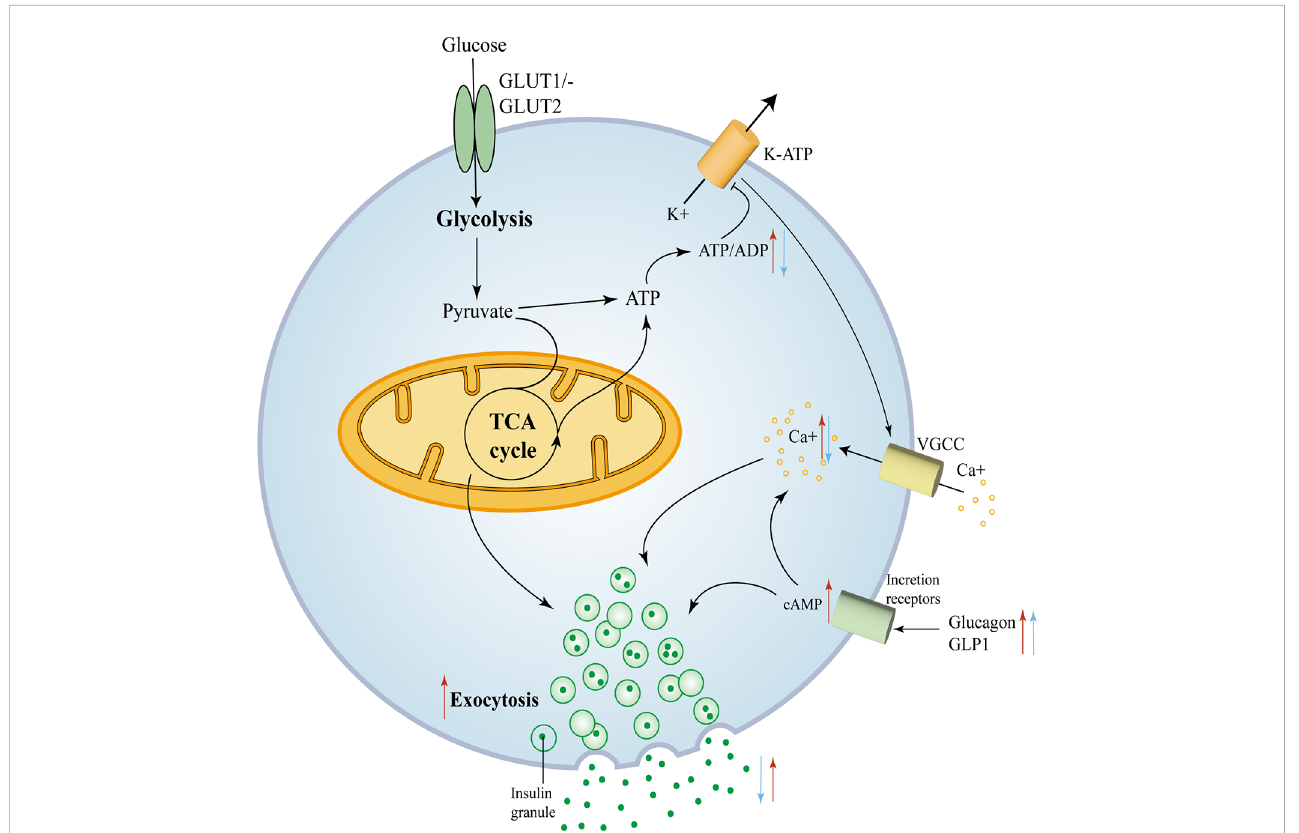
FIGURE 3 FOXA1 and FOXA2 control insulin secretion in mature Β cells. FOXA1 and FOXA2 control insulin secretion in mature Β cells. Glucose enters the Β cell and moves into the glycolytic pathway and is then oxidized through the tricarboxylic acid (TCA) cycle and subsequently produces ATP, with an elevated ATP/ADP ratio leading to the closure of KATP channels, membrane depolarization and subsequent opening of voltage-gated calcium channels. The consequent trigger phase of insulin granule cytokinesis is driven by an increase in intracellular calcium produced due to the opening of calcium channels (45). The red arrows mark key components of glucose metabolism and insulin secretion that are affected by the removal of FOXA2. The blue arrows mark key components that are affected by the removal of